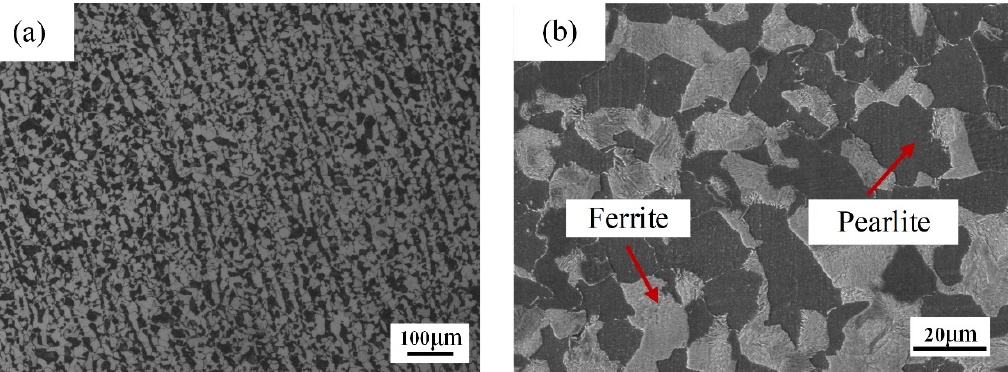
Figure 6. 20CrMnTiH organization before carburizing ( a ) Metallograph; ( b ) SEM.